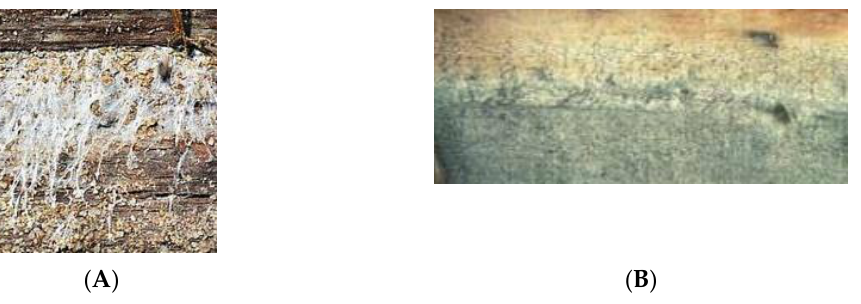
Figure 21. White rot fungi growing on a wood surface ( A ) and mold growing on a painted wood surface ( B ).